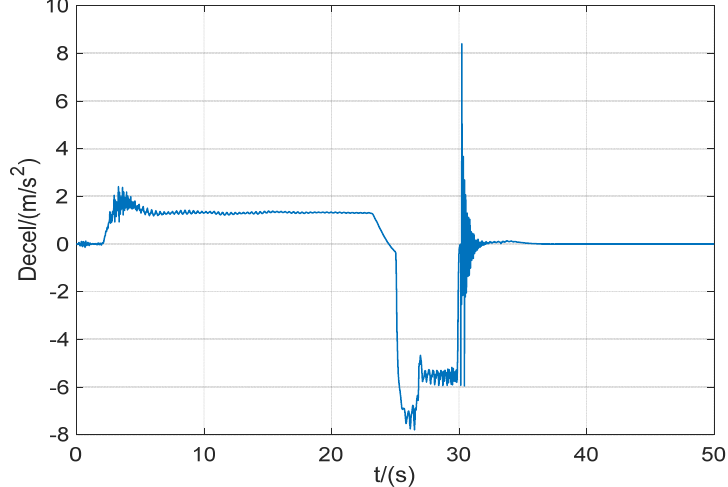
Figure 13. Vehicle deceleration-time.